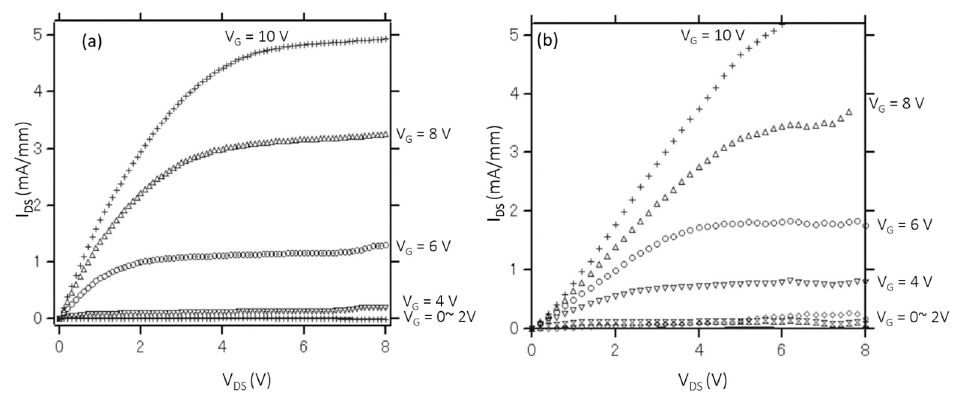
Figure 3. Output current–voltage (I d –V d ) characteristics of GaN-MOSFETs fabricated using the implantation technique ( a ) and regrowth method ( b ).